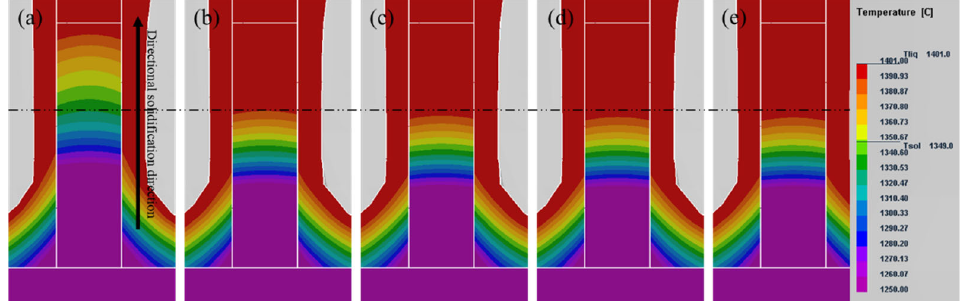
Figure 3. The temperature field of the seed segment with casting during the heating and holding stages. ( a ) Four min before the holding stage, and at holding times of ( b ) 0 min, ( c ) 2 min, ( d ) 4 min, and ( e ) 6 min.